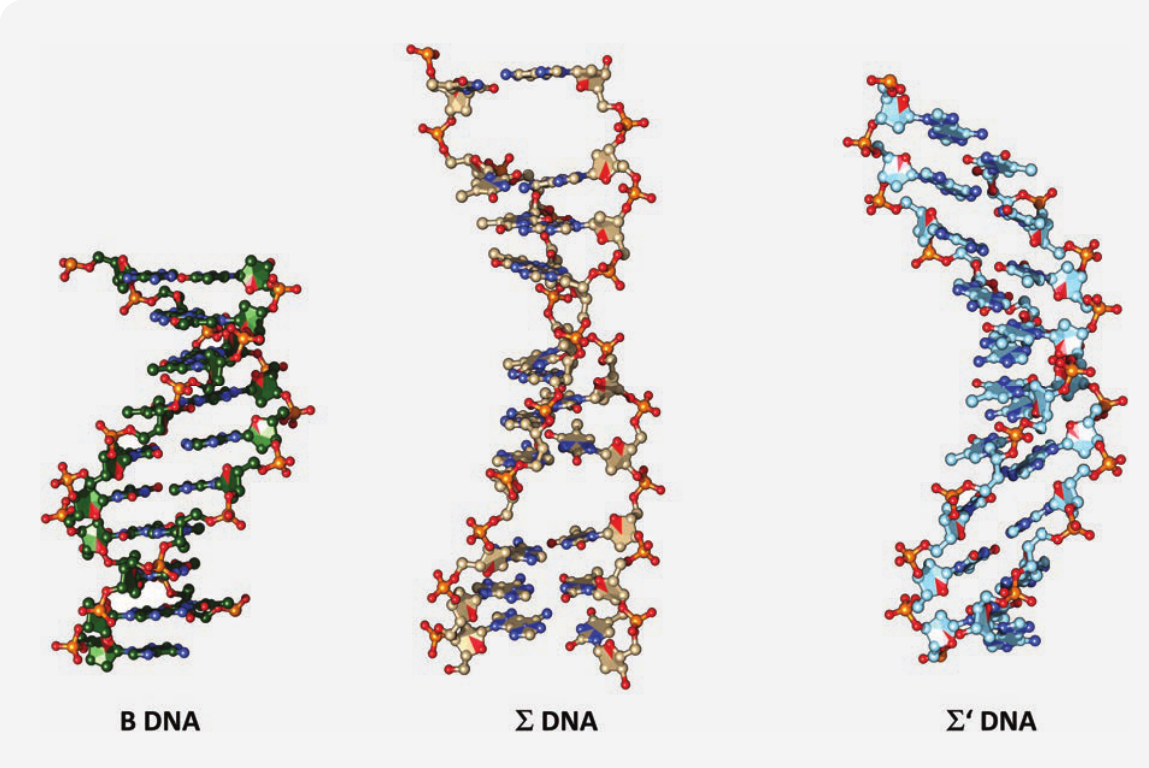
Figure 6. Two energetically plausible models for 50% elongated double-stranded DNA. Right: a homogeneously stretched model with tilted bases ( Σ′ ). Middle: an inhomogeneous model with perpendicular bases ( Σ ). Left: normal B DNA. From the perpendicular base orientation evidenced from Figs. 4, 5, the Σ′ structure was excluded in favor of Σ . Structures kindly provided by Dr Anna Reymer 26